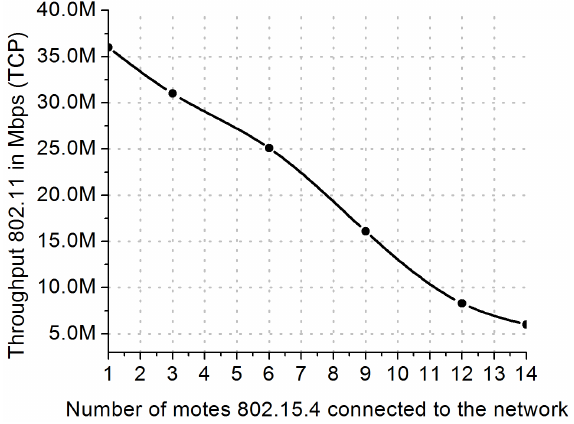
Figure 11. Variation in IEEE 802.11 throughput as new 802.15.4 motes are added to the